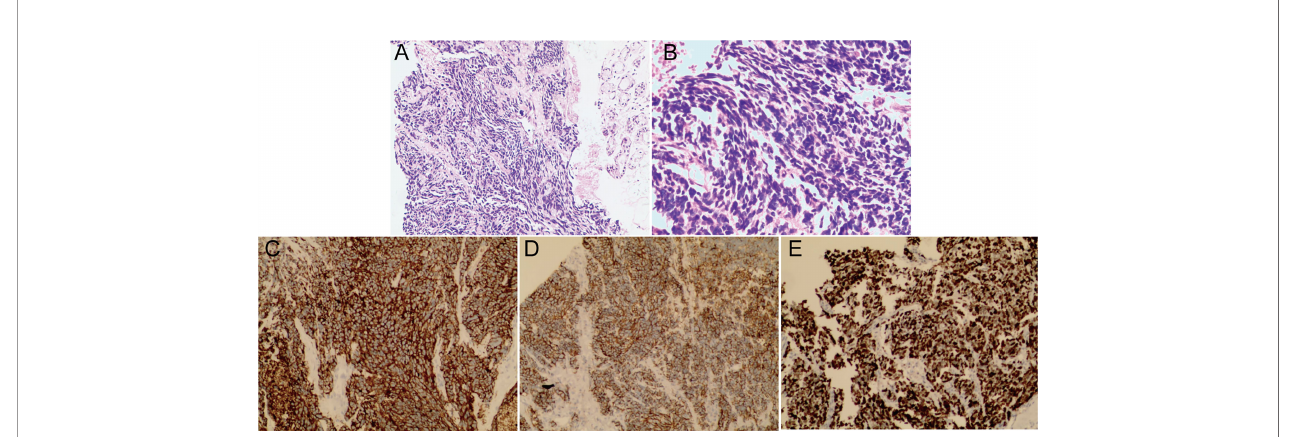
FIGURE 6 | Histopathological examination of the stained specimen under a high-power fi eld showed neoplastic cells arranged in solid sheets and short fusiform with light nuclei, fi ne chromatin, unclear nucleoli and a high mitotic rate consistent with the diagnosis of SCBC. ( A 10x, B 20x). Immunohistochemical analysis showed that Syn (C) and CD56 (D) were positive and Ki67 was 65% (E)